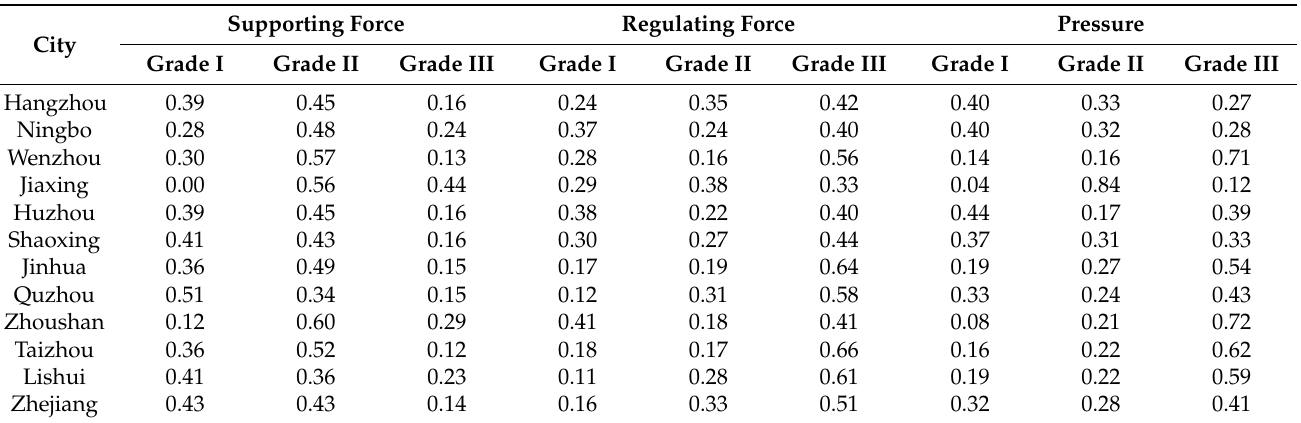
Table 5. Normalized results of measured values of each